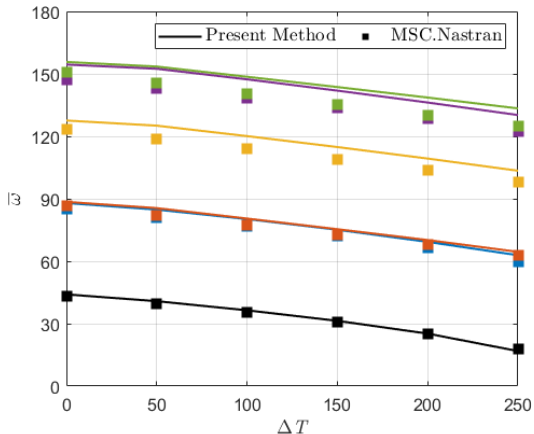
Figure 6. First six dimensionless natural frequencies of the clamped HCS plate against temperature change Δ T obtained from MSC.Nastran simulation and the present method.